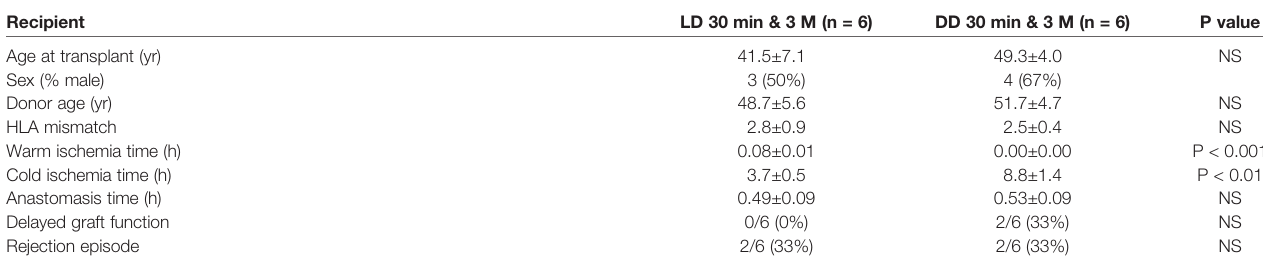
(B) Demographic and clinical characteristics of 33 patients for qPCR validation. Recipient Age at transplant